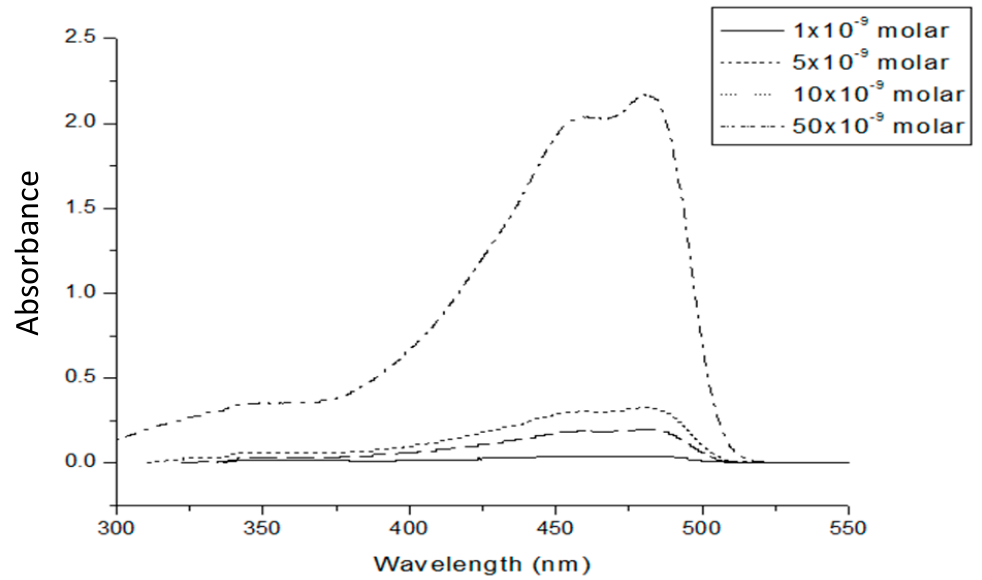
Figure 2. Absorption spectra of GP in toluene for concentration ranging from 1 nanomolar to 50